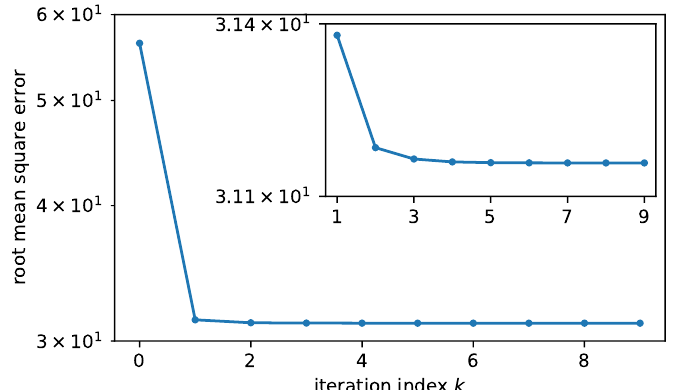
Figure 9. Root mean square error (RMSE) of the sinusoid fits to the empty beam phase stepping series throughout the iterations of Algorithm 1. After the first correction of the actual sampling locations by Equation (17), the error is reduced by almost a factor of two. The following iterations further reduce the error confirming the validity of Algorithm 1 for the solution of Equation (6). Additional consideration of spatially inhomogeneous stepping distances (Equation (2)) further reduces the RMSE by merely 0.1%.